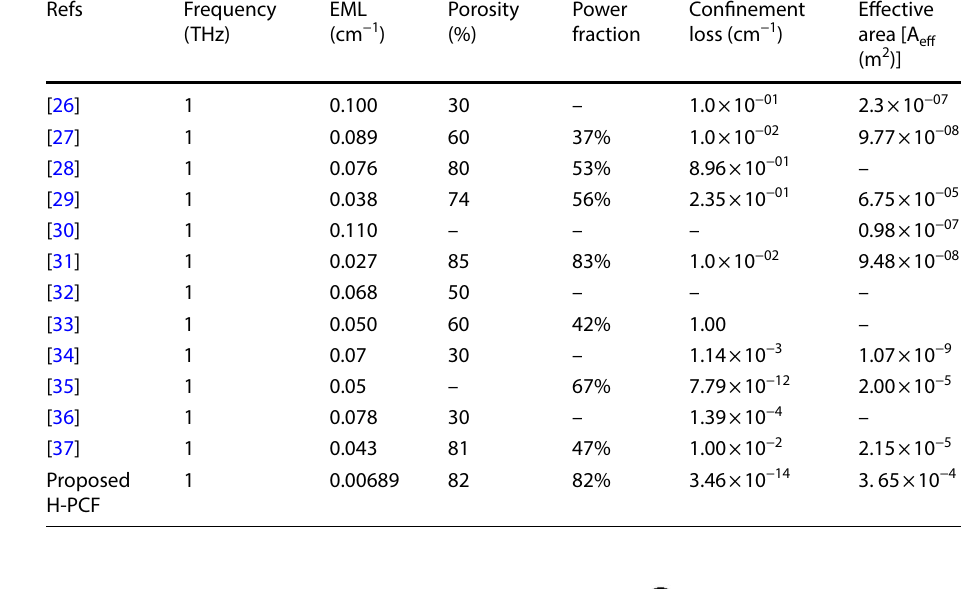
Fig. 1 The views of H-PCF fiber with ( a ) Hexagonal cladding region and (b) Rotated-hexa elliptical core